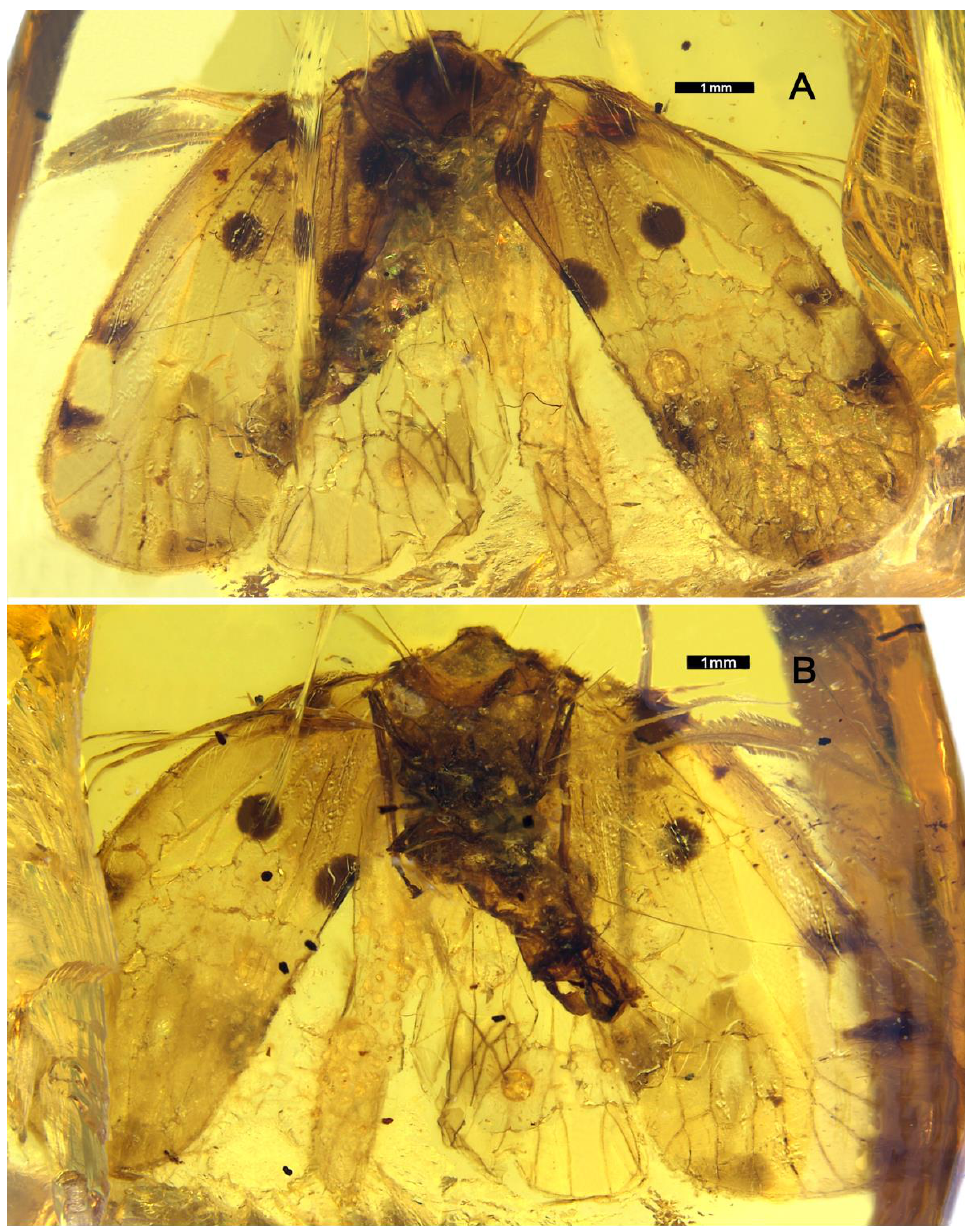
Figure 1. Maculixius jiewenae sp. nov. , Holotype, MDHP11. ( A ) Habitus, dorsal view. ( B ) Habitus, ventral view.